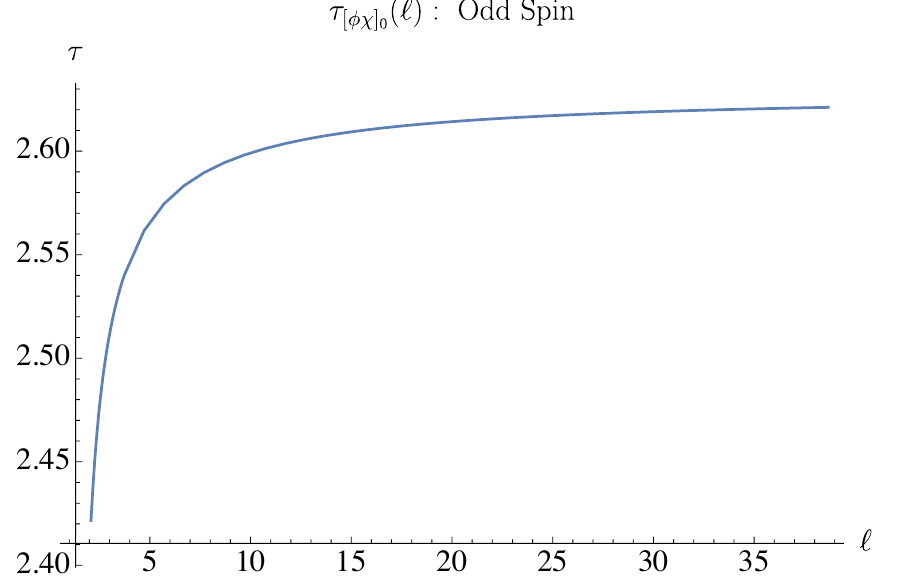
Figure 14 . Analytic predictions for twists of operators on the Regge trajectory [ (cid:30)(cid:31) ] 4 4 and odd spin.